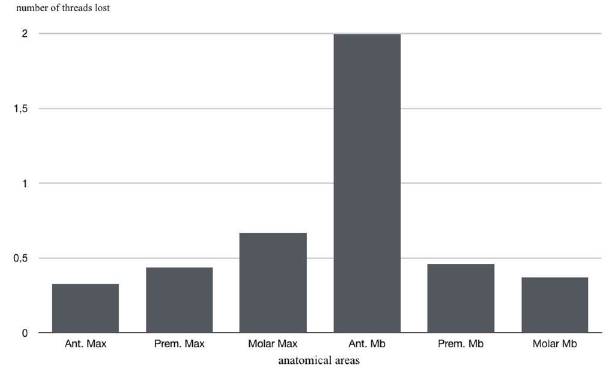
Figure 7. Mean thread loss in relation to implant location.